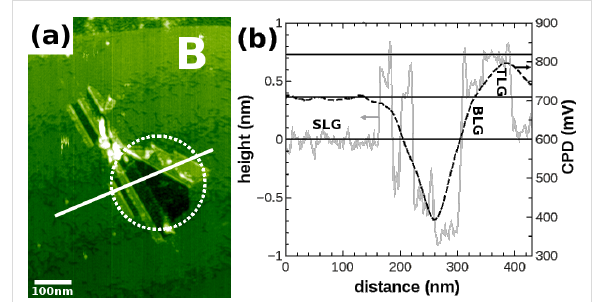
Figure 4: NC-AFM image (a) of an exfoliated SLG flake on 6H-SiC(0001), irradiated with SHI and subjected to post-preparation treatment, and its corresponding LCPD image (b). Folding structures, which result from post-preparation treatment labeled by A, B and C are